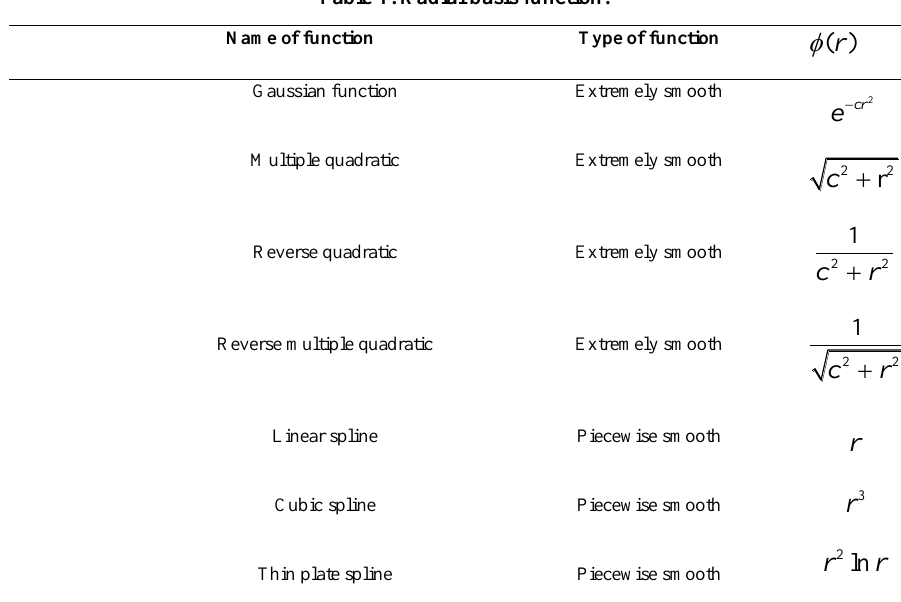
Table 1. Radial basis